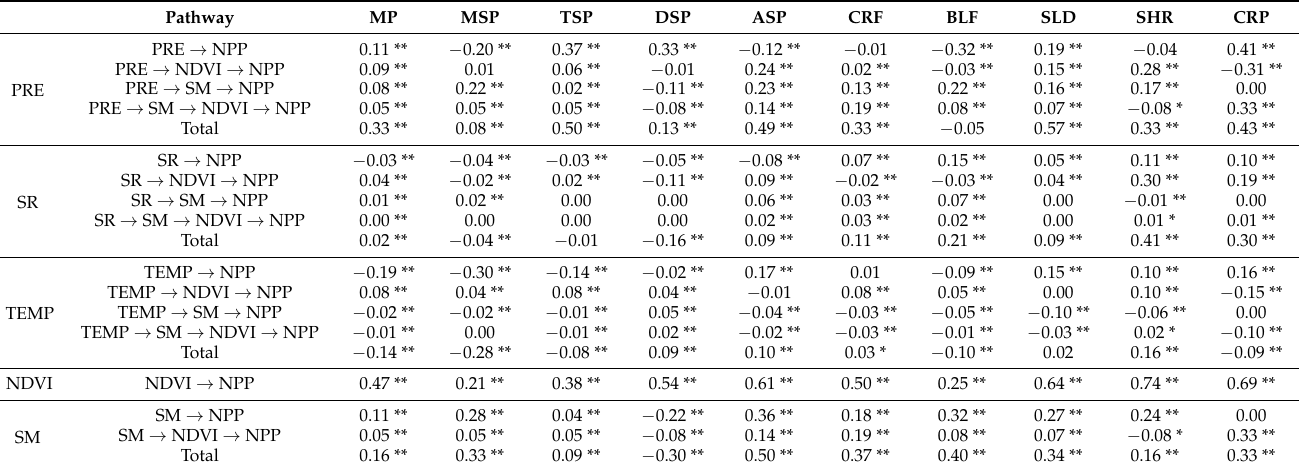
Table 2. The direct, indirect, and total effects of PRE, SR, TEMP, NDVI, and SM on NPP variations in the MP based on the